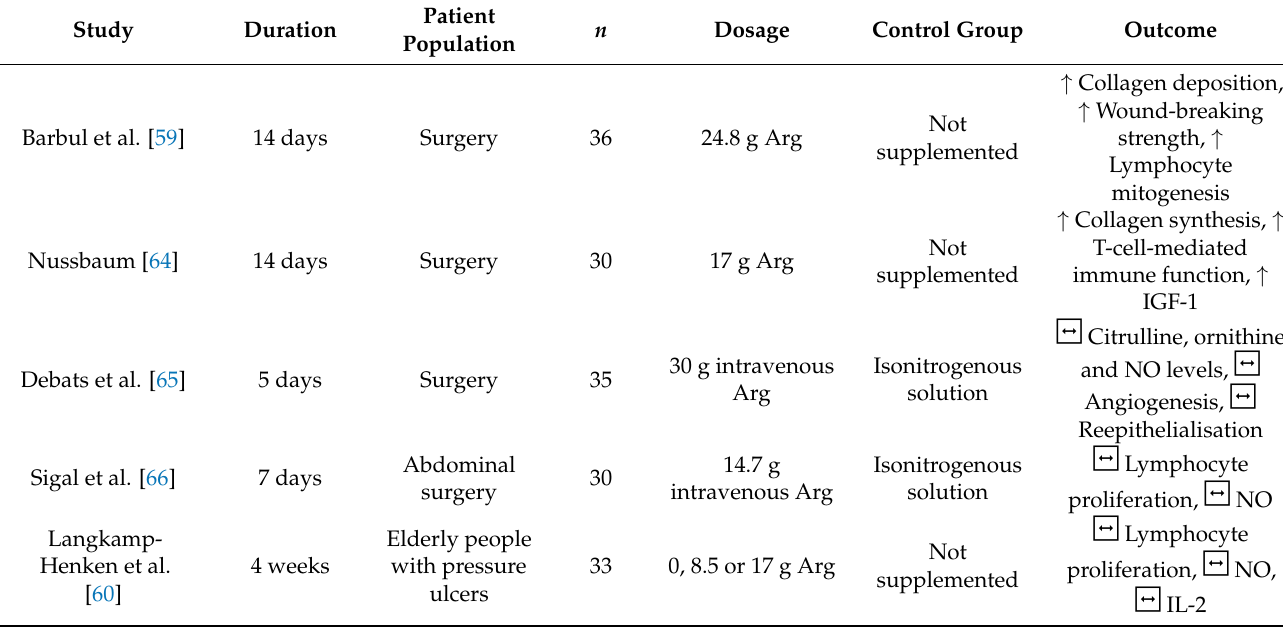
Table 2. Studies evaluating the effect of arginine supplementation on wound healing and reported outcomes. Study Debats et al. Sigal et al.